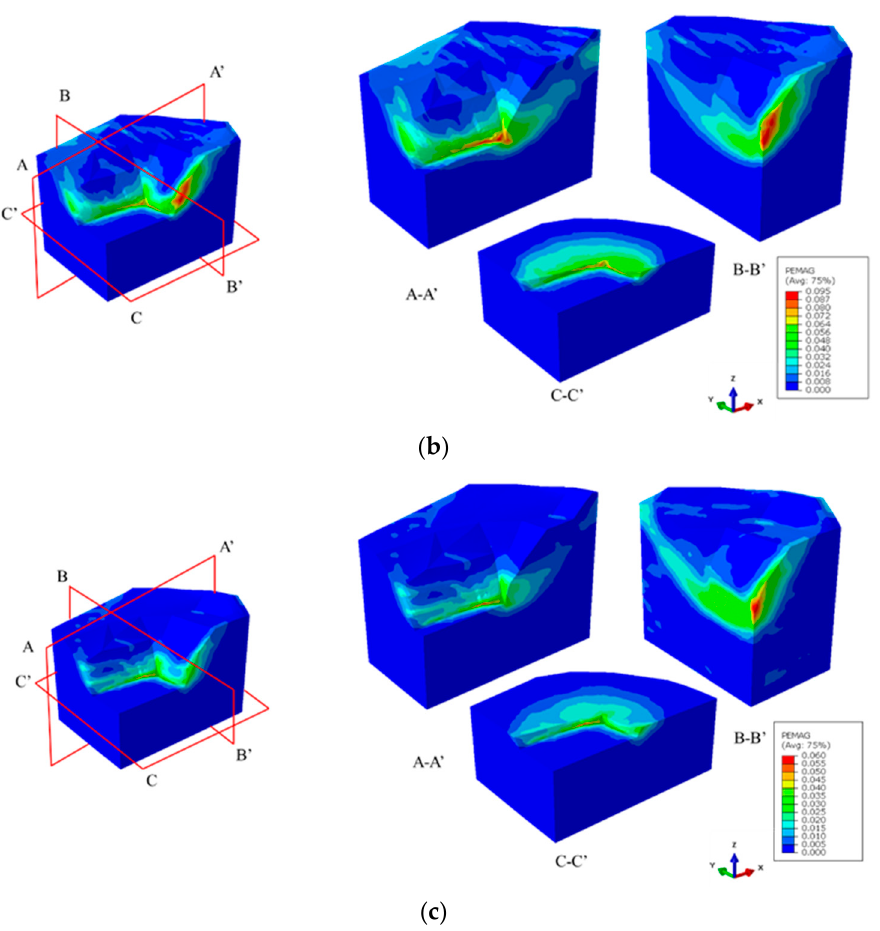
Figure 16. Plastic strain diagram of the slope with 60° rotation angle of the weak zones. ( a ) The rotation angle of 60° around the X -axis ( FOS = 1.89); ( b ) the rotation angle of 60° around the Y -axis ( FOS = 1.97); ( c ) the rotation angle of 60° around the Z -axis ( FOS = 1.98).